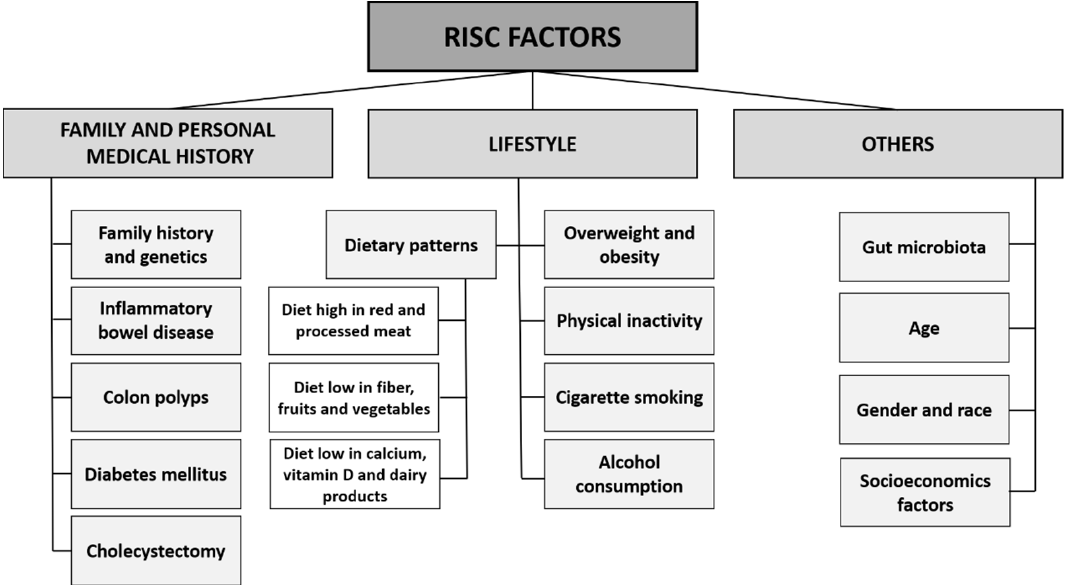
Figure 2. The main risk factors associated with colorectal cancer.